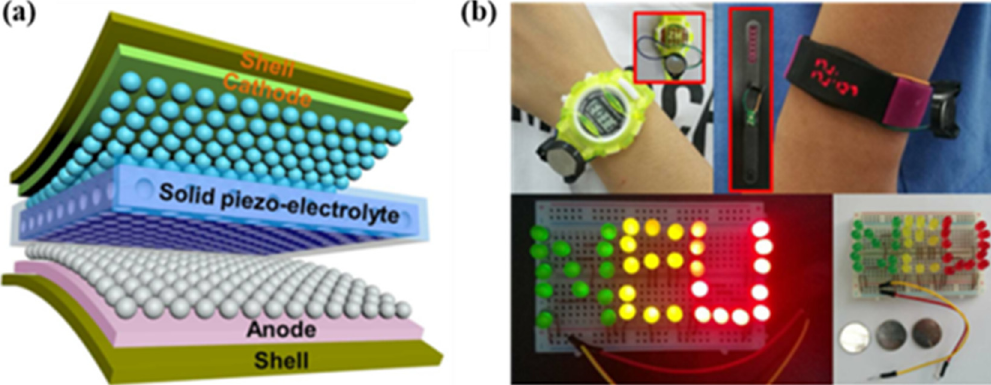
Figure 7. ( a ) The design principle of the all–solid–state self–charging power cell (SCPC). ( b ) Application of all–solid–state SCPCs, such as powering smart watches, sports bracelets, and LEDs. Reproduced with the permission from reference [69]. Table 3. Performances of the PVDF-based PENGs doped with semiconductor piezoelectric materials.